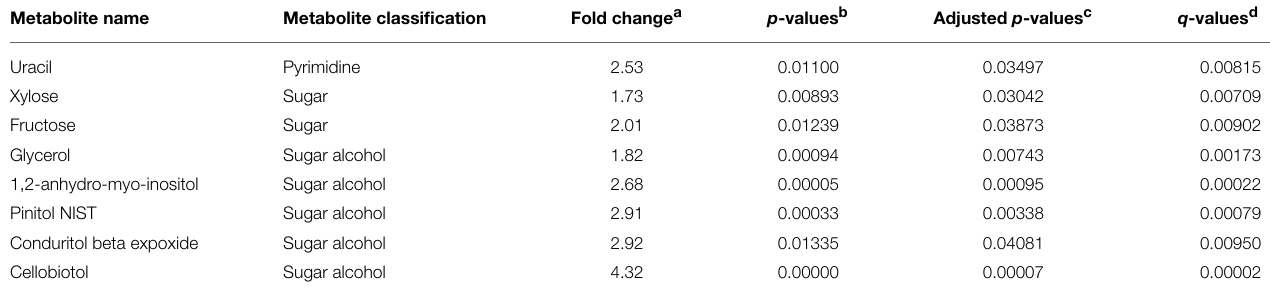
the test statics (i.e., p -values) were adjusted for the multiple hypotheses tested to allow for a maximum 5% probability ( q = 0 . 05 ) of false positives. Box and whiskers plots showing natural logarithm transformed values are used to visualize the group means and standard deviations.